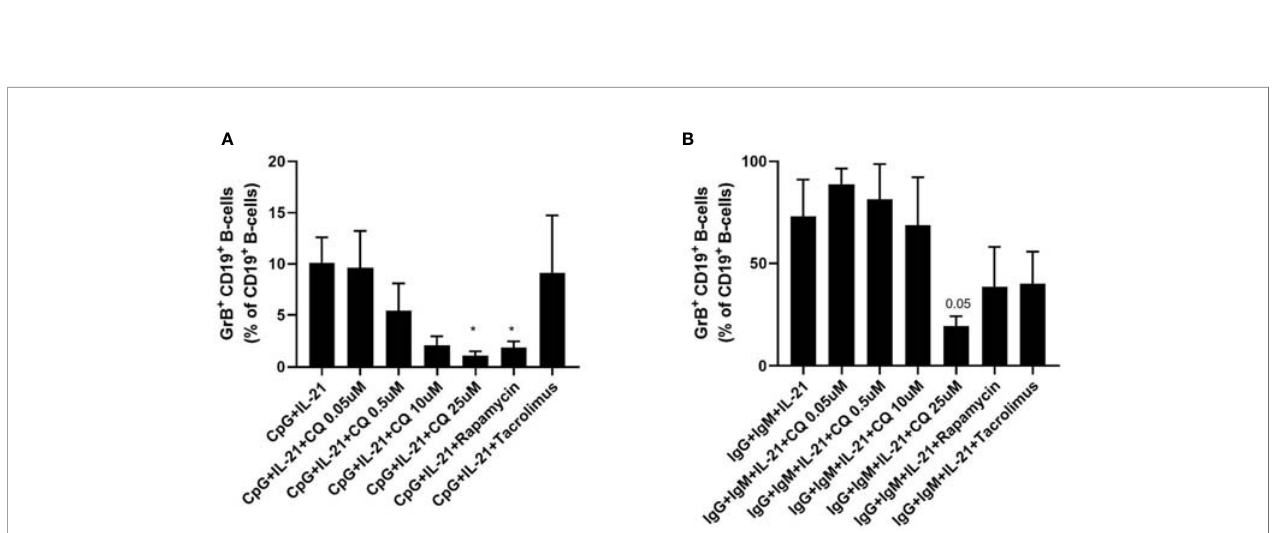
FIGURE 4 | Effect of CQ on GrB pos regulatory B-cells. Puri fi ed B cells were isolated and stimulated via TLR9 or BCR plus IL-21, in presence or absence of CQ, rapamycin or tacrolimus for 72 hours. After 72 hours, GrB + CD19 + B-cells were determined by fl ow cytometry. (A) Impact of CQ on GrB + CD19 + B-cells upon CpG plus IL-21 stimulation. (B) Impact of CQ on GrB + CD19 + B-cells upon IgG/IgM plus IL-21 stimulation. P-values were calculated by repeated-measures ANOVA and correction for multiple comparisons were done by Dunnett ’ s test. *p < 0.05 (against CpG+IL-21 or IgG+IgM+IL-21 as control